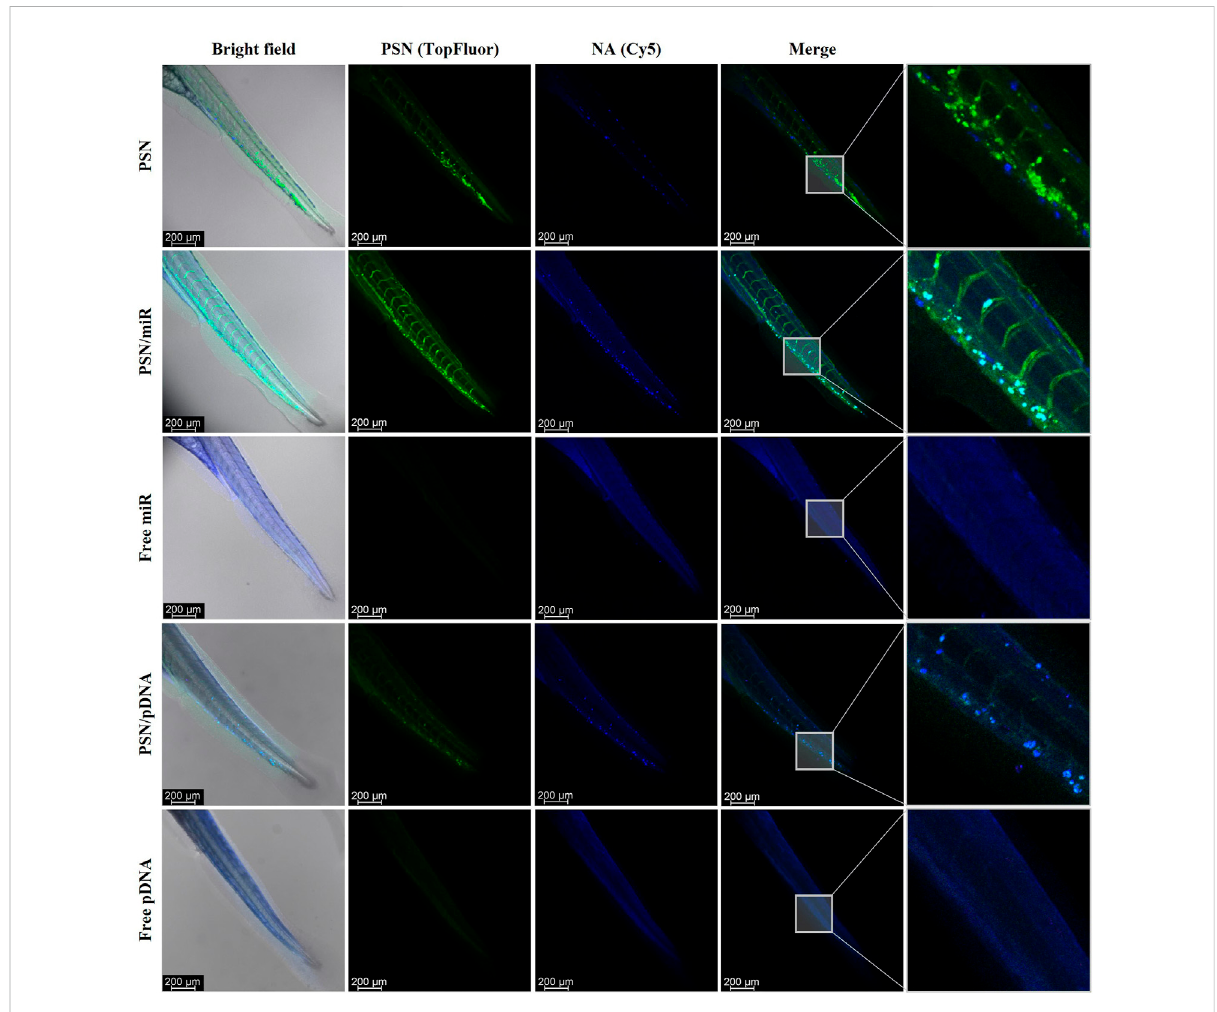
FIGURE 4 Confocal images of in vivo biodistribution of TopFluor-labelled nanoemulsions (green) with and without miR-Cy5 and pDNA (blue), after 48 h incubation in microinjected 48 hpf zebra fi sh